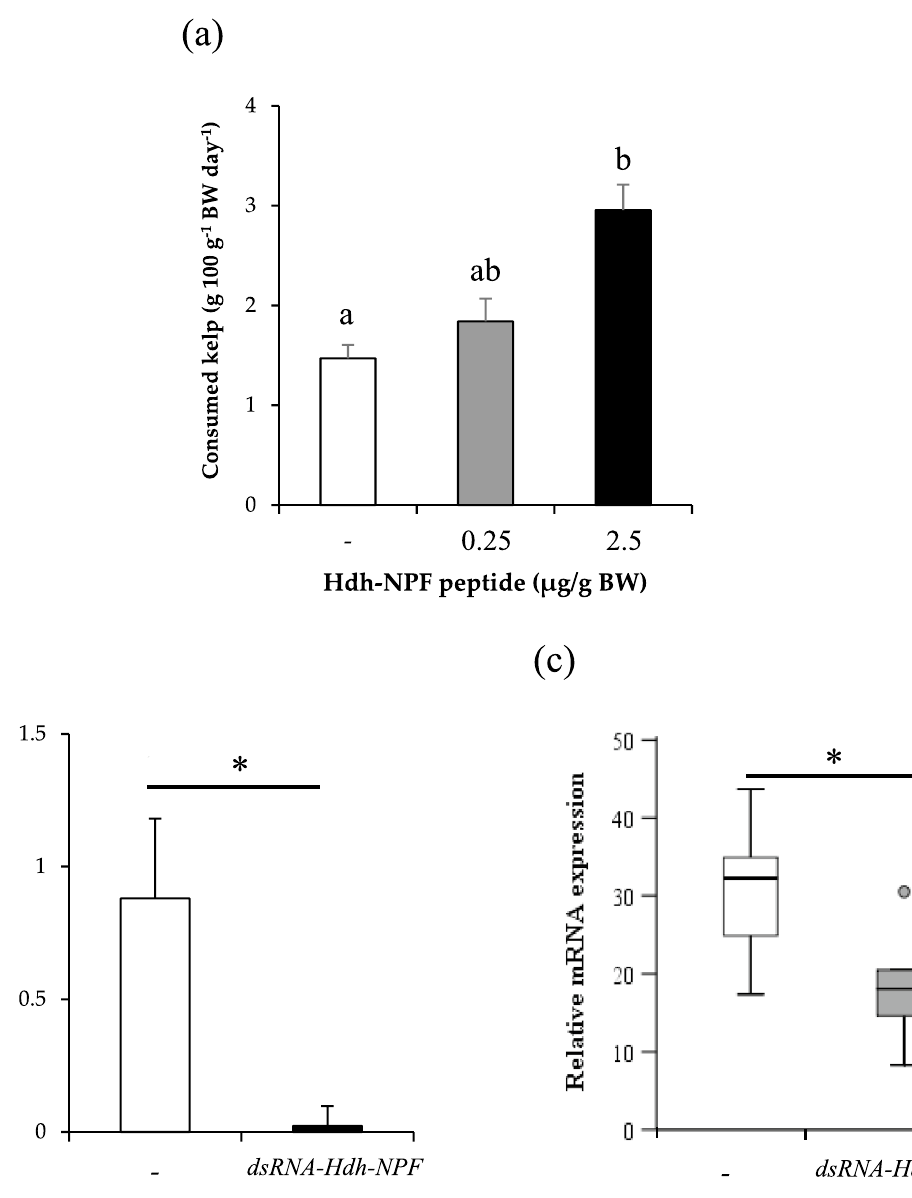
Figure 5. Effect of Hdh-NPF and double-stranded RNA of Hdh-NPF mRNA on food intake in abalone. ( a ) Effect of in vivo administration of Hdh-NPF peptide on kelp consumption in abalone. Each column and bar represent the mean and SEM (n = 11 per group), respectively. Significances of differences were evaluated by one- way analysis of variance with the Bonferroni correction method in comparison with the mollusk saline-injected group. Different lowercase letters indicate significant differences between treatments ( P < 0.05). ( b ) Effects of Hdh-NPF knockdown on food intake. For RNA interference, individual abalone were injected with 165 μg of dsRNA-Hdh-NPF or the same volume of mollusk saline. Feeding assays were performed on the third day after injection. Results represent means ± SEM (n = 10 per group); *significant difference ( P < 0.05) by Student’s t -test. (c) Relative Hdh-NPF transcript levels in the cerebral ganglia of abalone. The Hdh-NPF transcript levels in dsRNA-Hdh-NPF - or saline-injected abalone were measured by RT-qPCR. The ribosomal protein L-5 ( Hdh-RPL5 ) was used as the internal control. Results represent means ± SEM (n = 10 per group); *statistical significance ( P < 0.05) by Mann–Whitney U